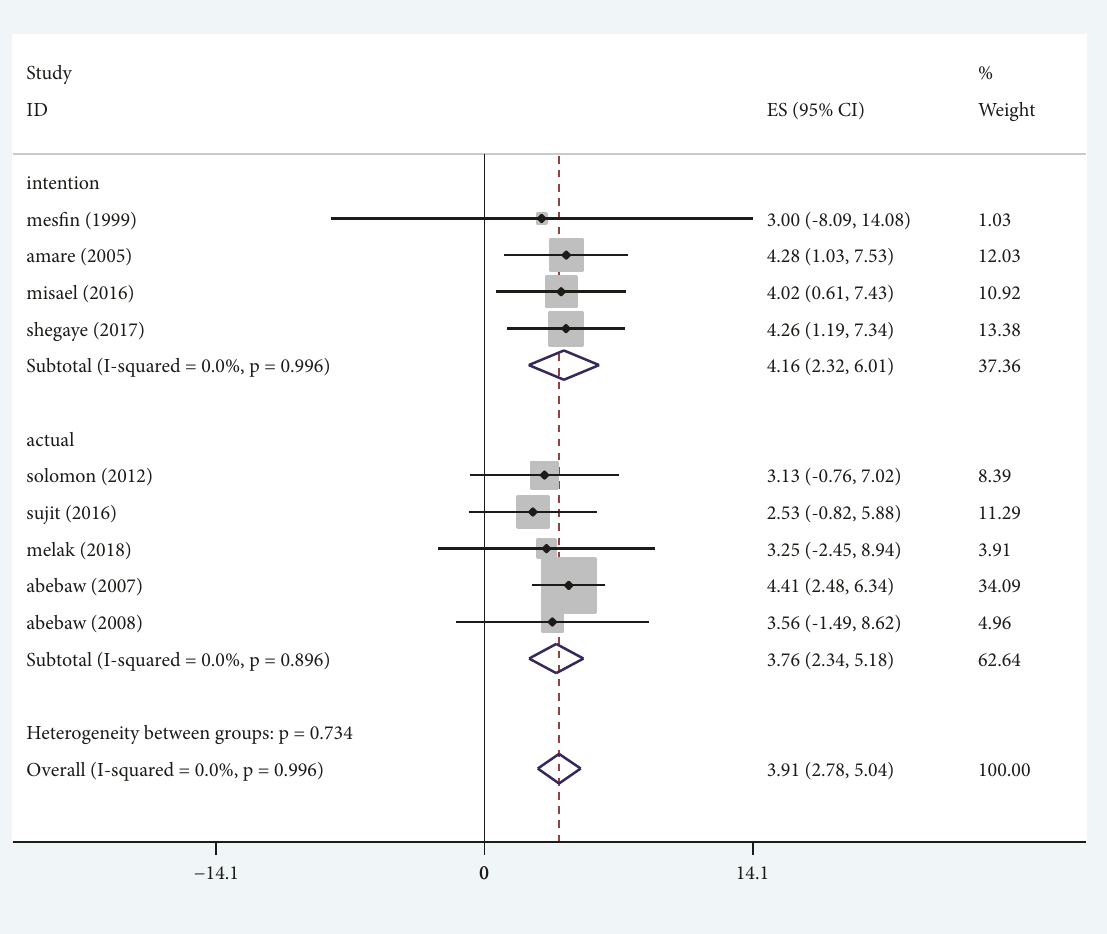
Figure 3: Forest plot presenting the help seeking intention and behaviour using random effect models with 95%